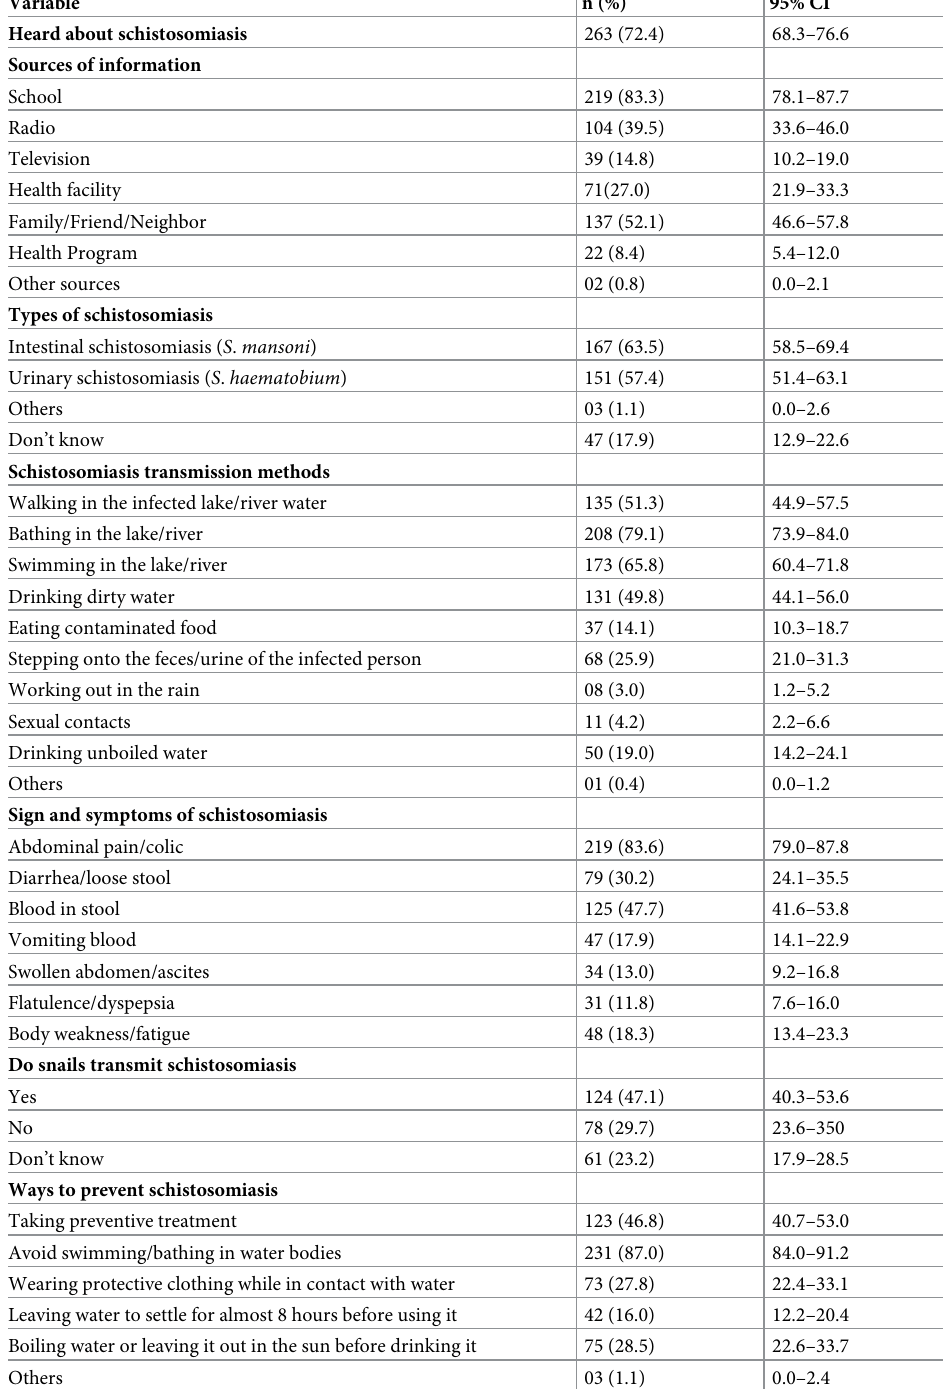
Table 2. Summary of knowledge on intestinal schistosomiasis among the